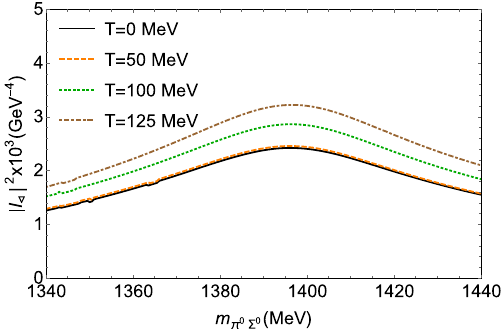
Fig. 2 Squared modulus of triangle loop integral ( | I (cid:4) | 2 ) in Eq. (6) for the reaction (8) as function of m π 0 (cid:9) 0 [12] at finite T , with intermediate particles 1, 2 and 3 being K ∗ 0 ,(cid:9) 0 ,π 0 respectively. The invariant mass of K ∗ 0 (cid:9) 0 isfixedat2140MeV.Massesandwidthstakenattheirvacuum values[24]exceptforaregulating Γ 2 ,Γ 3 = 0 . 2MeVtoavoidnumerical instability (so the peak, ∝ log Γ [25], is underestimated)